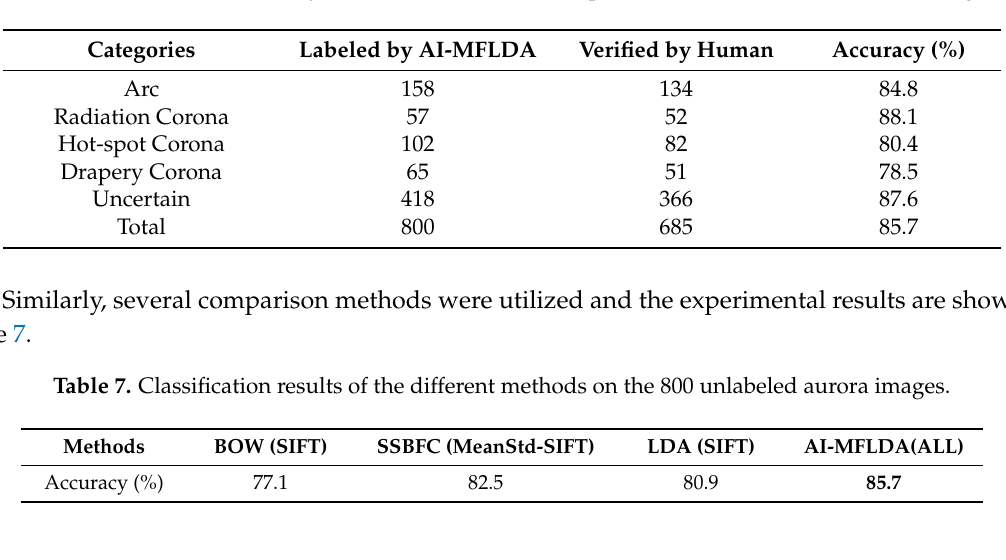
Figure 10. Classification accuracy values based on AI-MFLDA with different topic numbers with the four-class aurora image dataset.